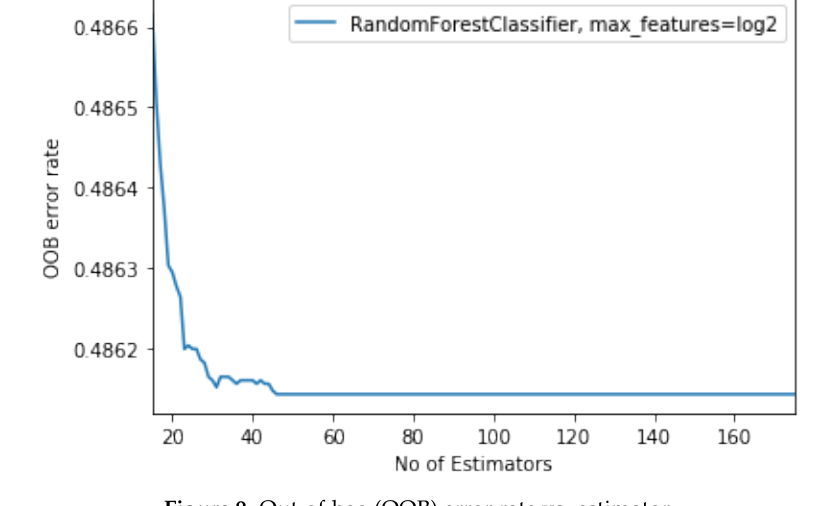
Figure 9. Out-of-bag (OOB) error rate vs. estimator.